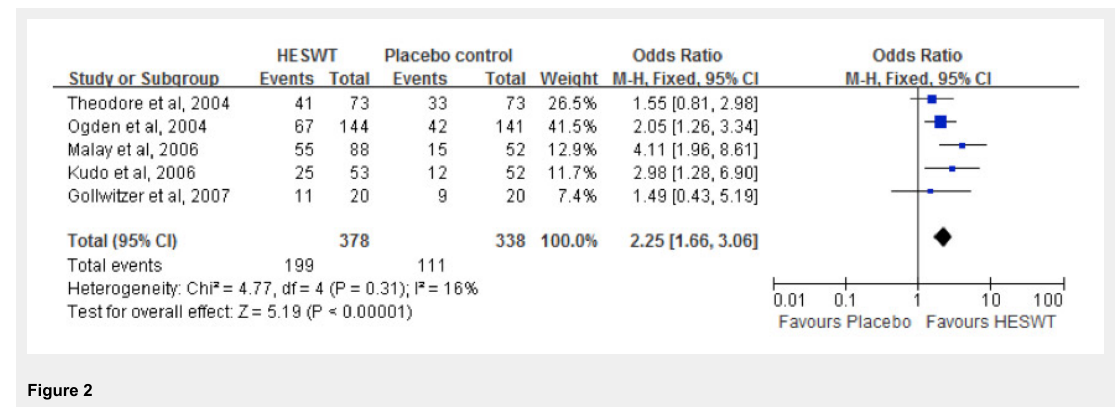
Figure 2 Forest plot of the five